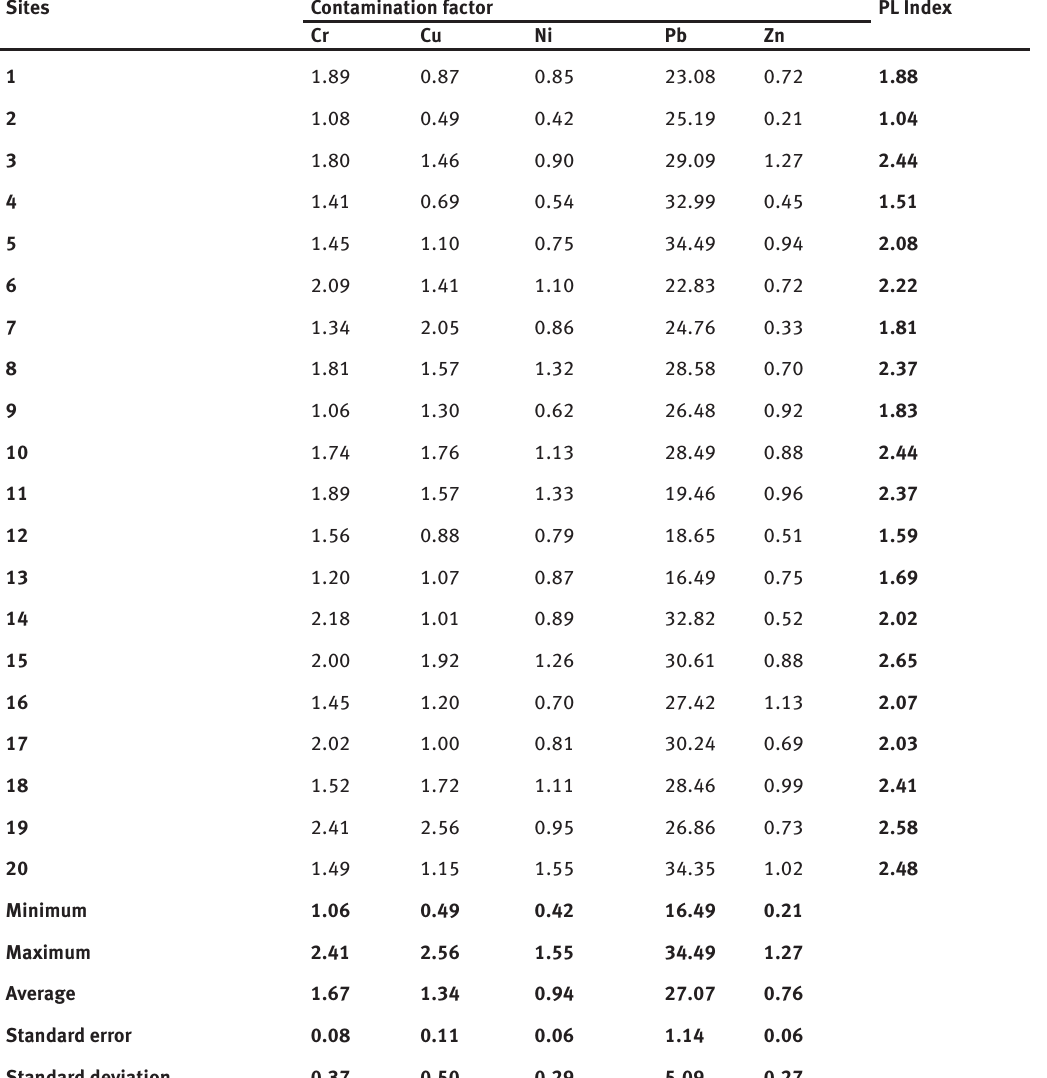
Table 6: Contamination factor, pollution index and degree of pollution of heavy metals in studied soils around cement factory.